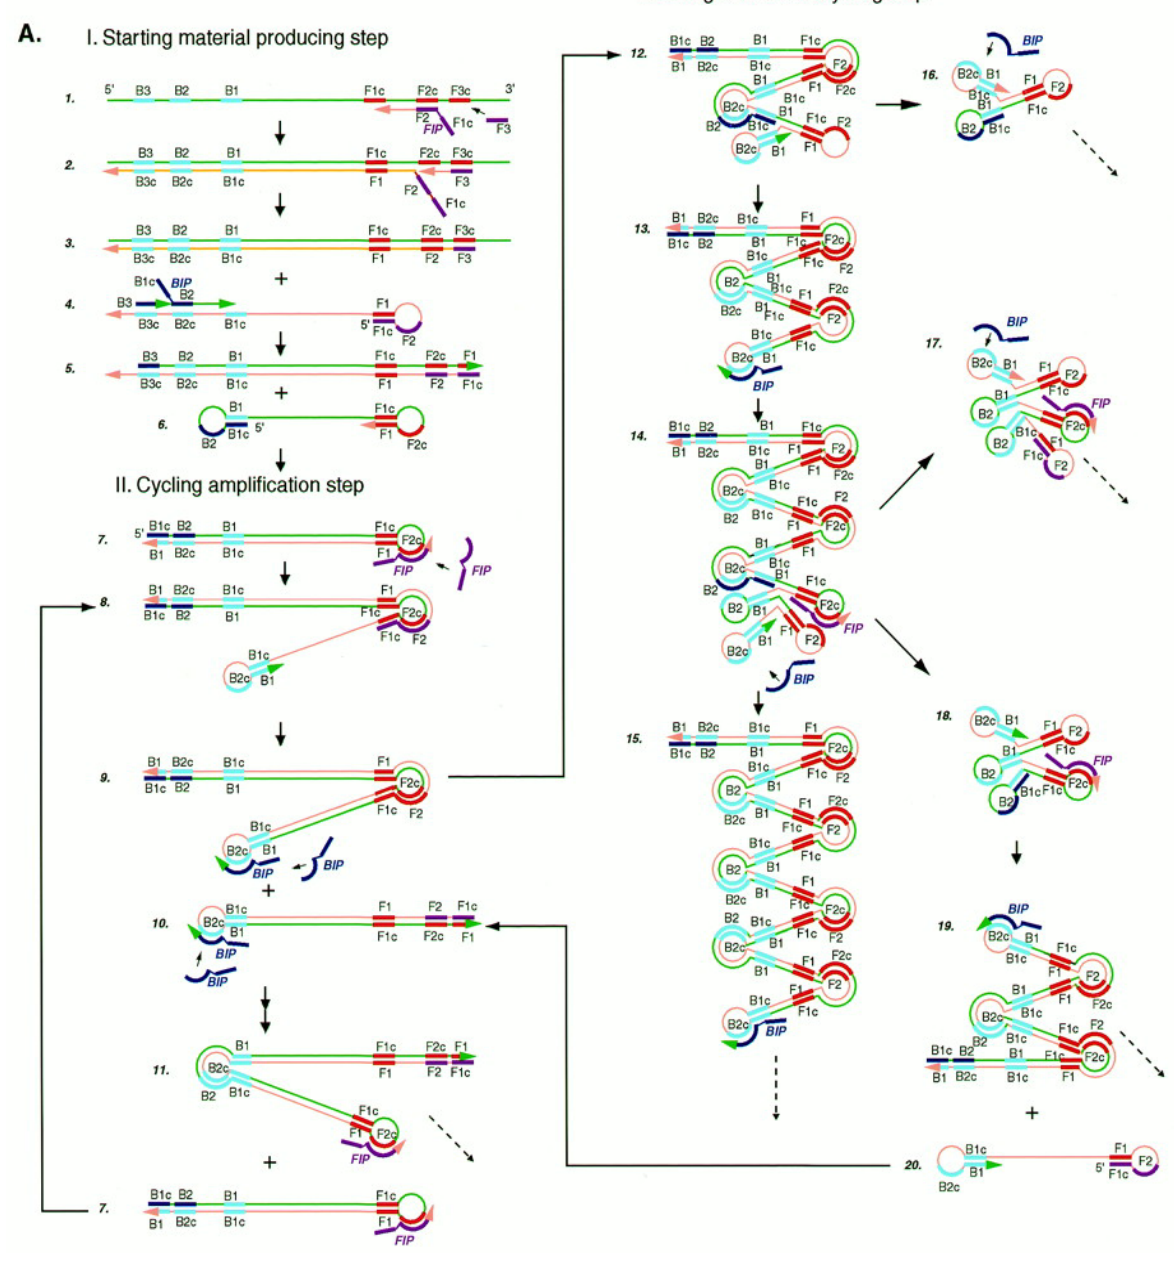
Figure 1. Schematic representation of the loop-mediated isothermal amplification (LAMP) amplification process. Adapted with permission from